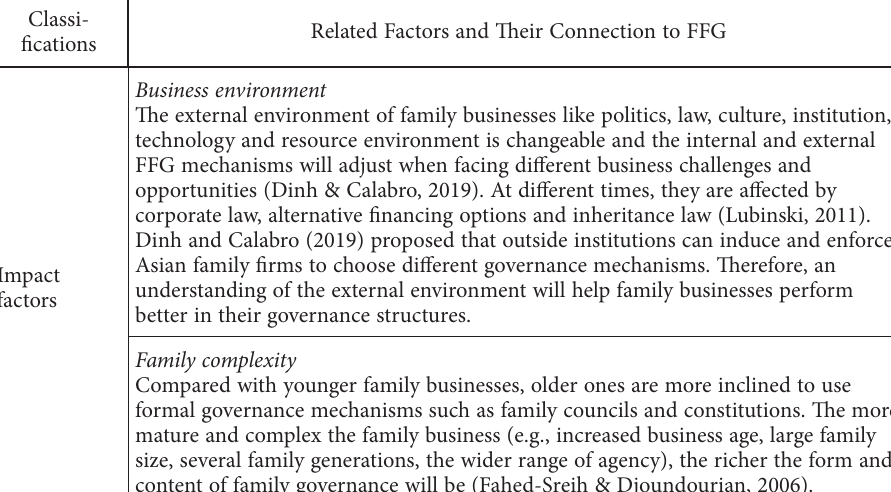
Table 1. The factors associated with FFG Classi- fications